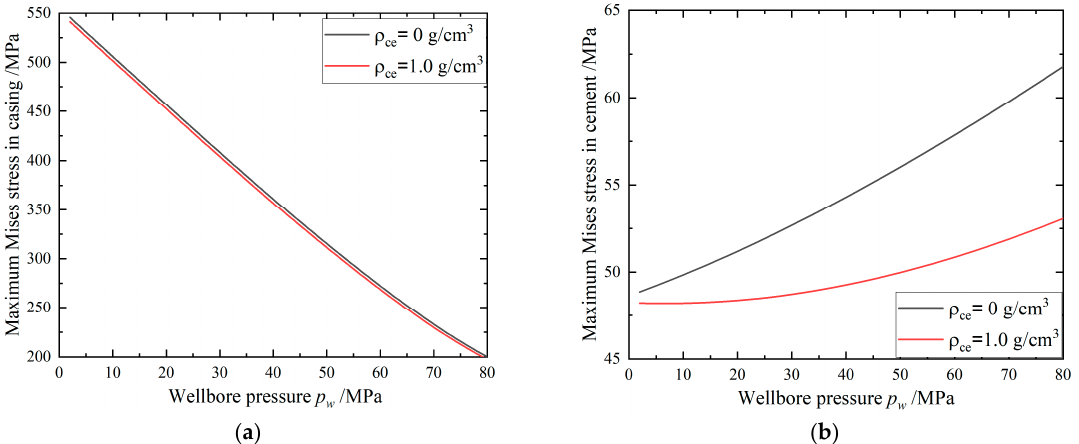
Figure 12. The initial stress state of cement’s effect on the maximum von Mises stress in ( a ) casing and ( b ) cement in the present 3D model for the given speci fi c parameters in Table 1.